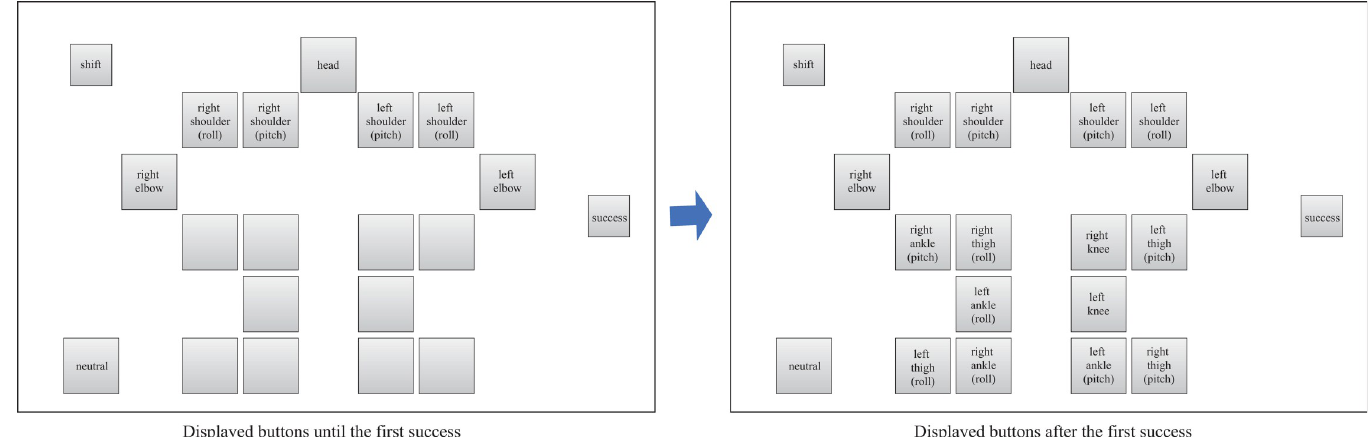
Fig 4. Command layout of the NAFS controller displayed on the tablet